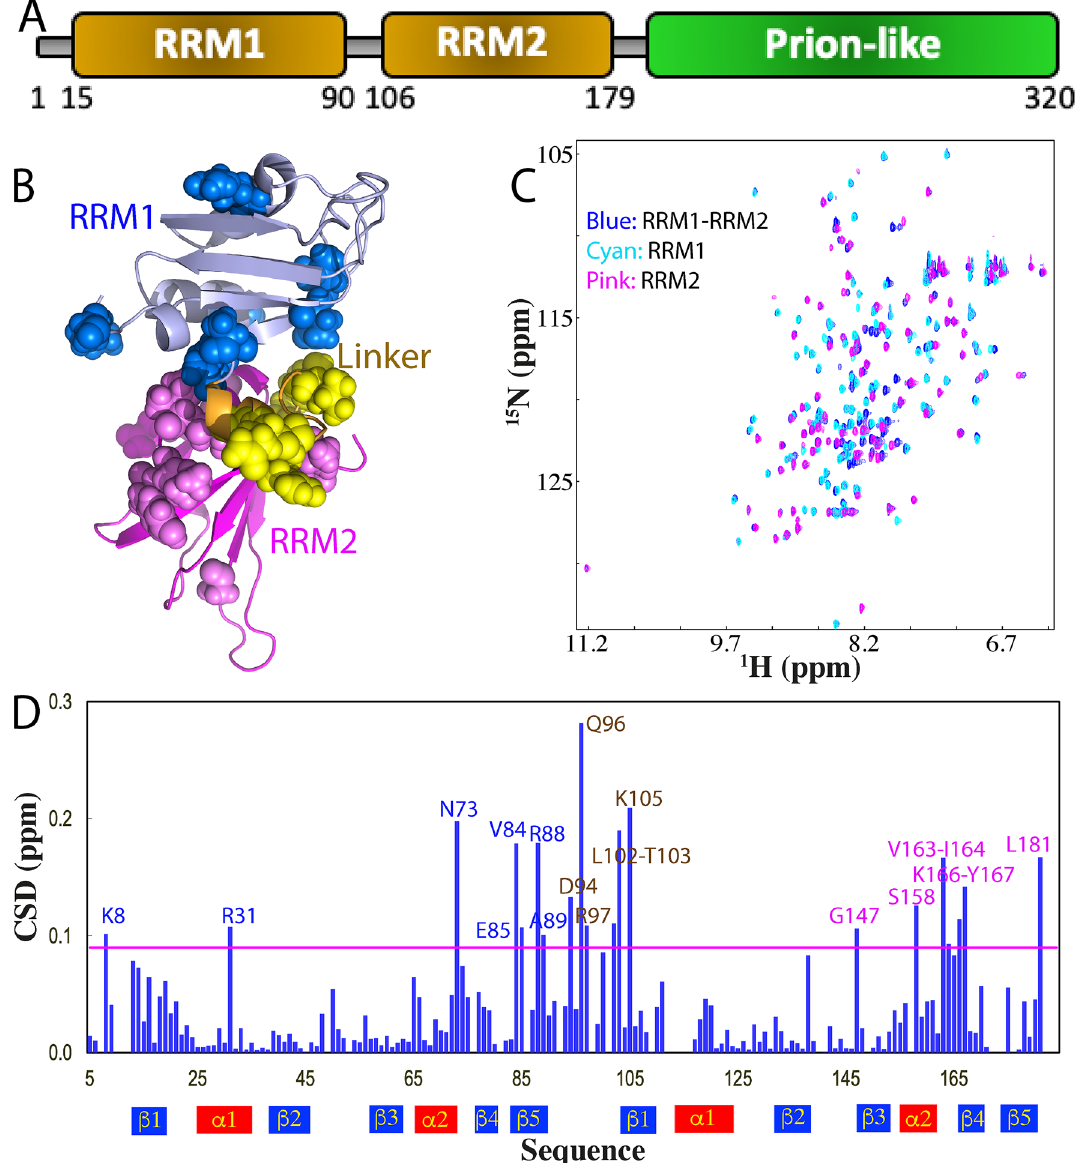
Figure 3. Dissection-induced perturbation of hnRNPA1 RRM domains. ( A ) 320-residue hnRNPA1 contains: two RNA recognition motifs (RRM1 and RRM2) over residues 1–179, and C-terminal prion-like domain over residues 180–320. ( B ) NMR structure (PDB ID of 2LYV) of the hnRNPA1 RRM1 (light blue) and RRM2 (pink) in which the residues are displayed in spheres for those with HSQC peaks significantly shifted in RRM1 (blue) or in RRM2 (light pink) upon dissection. The image was prepared by PyMol2.4 (https ://pymol .org). ( C ) Superimposition of 1 H- 15 N NMR HSQC spectra of the 15 N-labeled tethered RRM1–RRM2 domains (blue), the isolated RRM1 (cyan) and RRM2 (pink) domains at 50 μM in 10 mM sodium phosphate buffer (pH 6.8) containing 150 mM NaCl and 10 mM DTT. ( D ) Residue-specific chemical shift difference (CSD) of the RRM1 and RRM2 domains between the tethered and isolated forms. Significantly shifted residues are labeled and displayed as spheres, which are defined as those with the CSD values > 0.09 (average value + one standard deviation) (pink